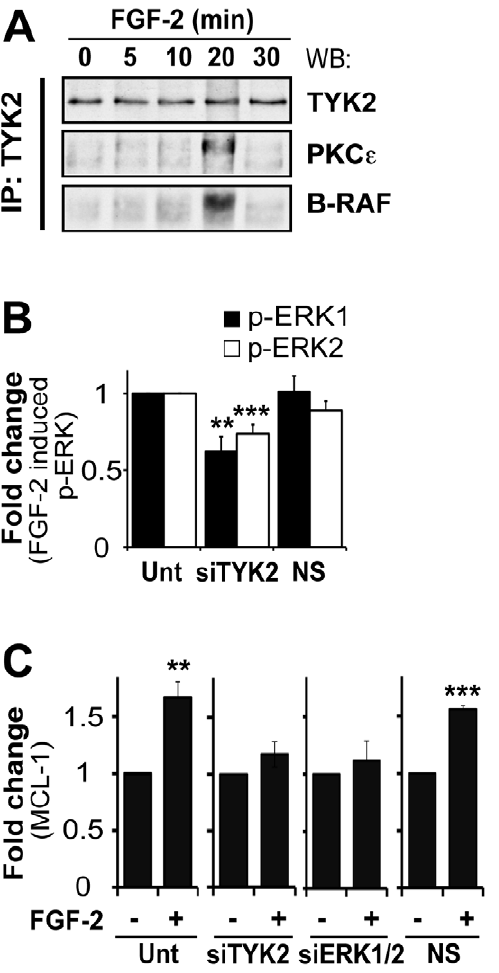
Figure 6. TYK2 played an important role in FGF-2-mediated drug resistance. A. FGF-2 induced interaction of TYK2 with PKC e and B-RAF in U2OS cells. Cells were treated as previously described and proteins isolated using co-immunoprecipitation buffer. TYK2 was immunoprecipitated from whole cell lysates and immunoprecipitates were analyzed using western blots. Membranes were probed for PKC e , B-RAF and TYK2, the latter used here as a loading control. B. and C. TYK2 silencing in U2OS cells led to decreased ERK1/2 phosphorylation and inhibited the upregulation of MCL1 in response to FGF-2. Cells were transfected with siTYK2 as before. Untransfected cells and cells transfected with a non-specific siRNA (NS) were used as controls. After 48 h, cells were treated as described previously and then stimulated with FGF-2 for ( B ) 10 min and ( C ) 4 h. B. Proteins were analyzed using antibodies against p-ERK1/2 (Thr 202/185 /Tyr 204/187 ) and total ERK1/2. Values correspond to phospho-ERK1 and -ERK2 levels. C. Western blotting analysis was performed using total cell lysates and anti-MCL1 antibody. b -actin was used as a loading control and for normalization. Mean 6 SEM of densitometric values of three independent experiments are shown.